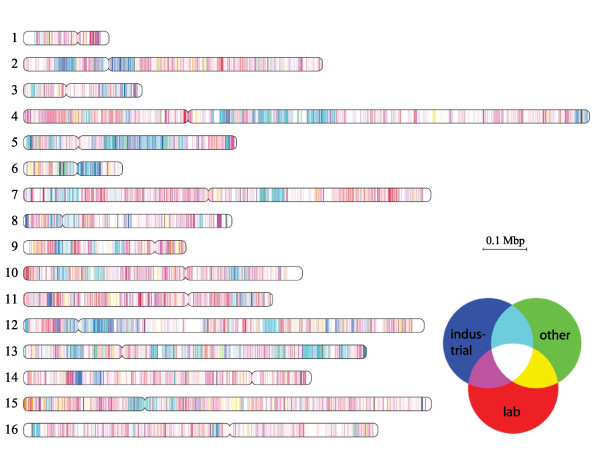
Mosaic CEN.PK113-7D genome. CEN.PK chromosomes colored by their identity to S. cerevisiae genomes, which were divided into the groups: laboratory (lab) (FL100:PRJNA60147, S288C:PRJNA128, Sigma1278b:PRJNA39317), industrial (e.g. wine, beer, bio-ethanol) (AWRI1631:PRJNA30553, AWRI796:PRJNA48559, CBS7960:PRJNA60391, CLIB382:PRJNA60145, EC1118:PRJEA37863, FostersB:PRJNA48569, FostersO:PRJNA48567, JAY291:PRJNA32809, Kyokai no. 7:PRJNA45827, Lalvin QA23:PRJNA48561, M22:PRJNA28815, PW5:PRJNA60181, RM11-1a:PRJNA13674, T73:PRJNA60195, UC5:PRJNA60197, Vin13:PRJNA48563, VL3:PRJNA48565, YJM269:PRJNA60389) and other (CLIB215:PRJNA60143, CLIB324:PRJNA60415, EC9-8:PRJNA73985, T7:PRJNA60387, Y10:PRJNA60201, YJM789:PRJNA13304, YPS163:PRJNA28813) (Additional file 12: Table S7). Each group was assigned one of the color channels of the RGB figure (red: lab, green: other and blue: industrial). The genome was divided in non-overlapping fragments of 1000 base pairs, represented by one pixel in the figure, which were aligned to the available S. cerevisiae genomes in GenBank (Additional file 12: Table S7). The identity of the best alignment in a group was set to be the value of the corresponding color channel. These values were scaled between 0 and 1; 0 meaning a maximal identity of 97% or lower, 1 meaning a maximal identity of 100%. For example, a white pixel color means 100% conservation of the fragment in all three groups. Blue and cyan mean conservation in industrial strains, but not in laboratory strains.